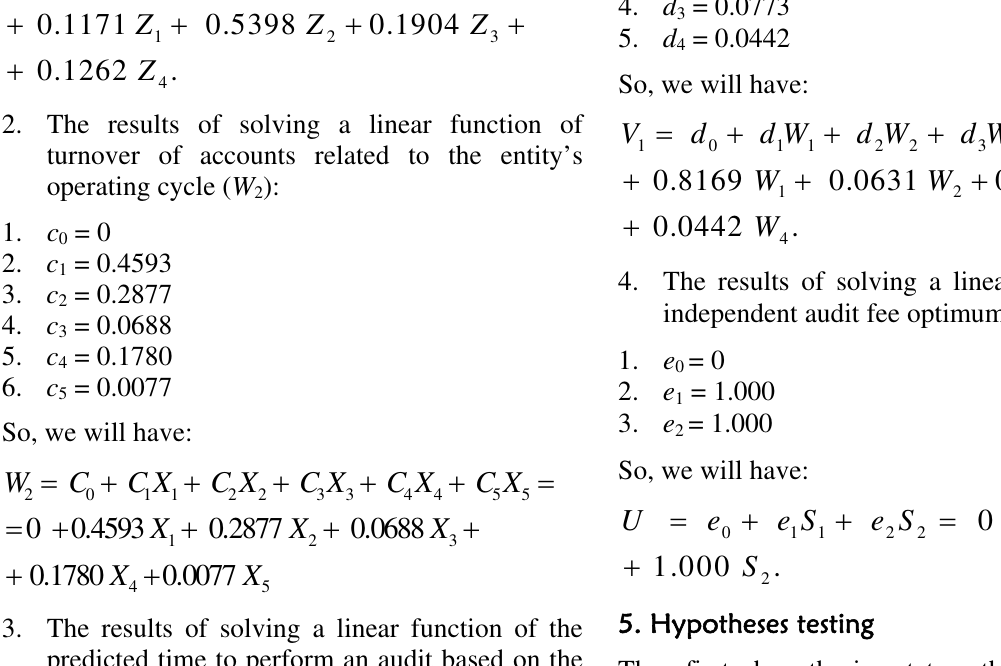
Table 13. The first hypothesis test result (normality test and correlation analysis) N 10 10 Mean Normal parameters a